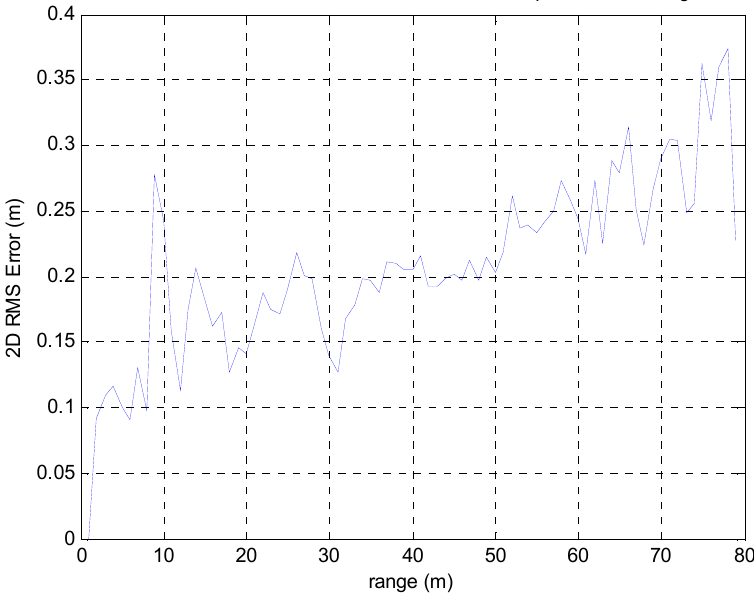
Figure 25. 2D RMS error of the extracted corners with respect to each distance.